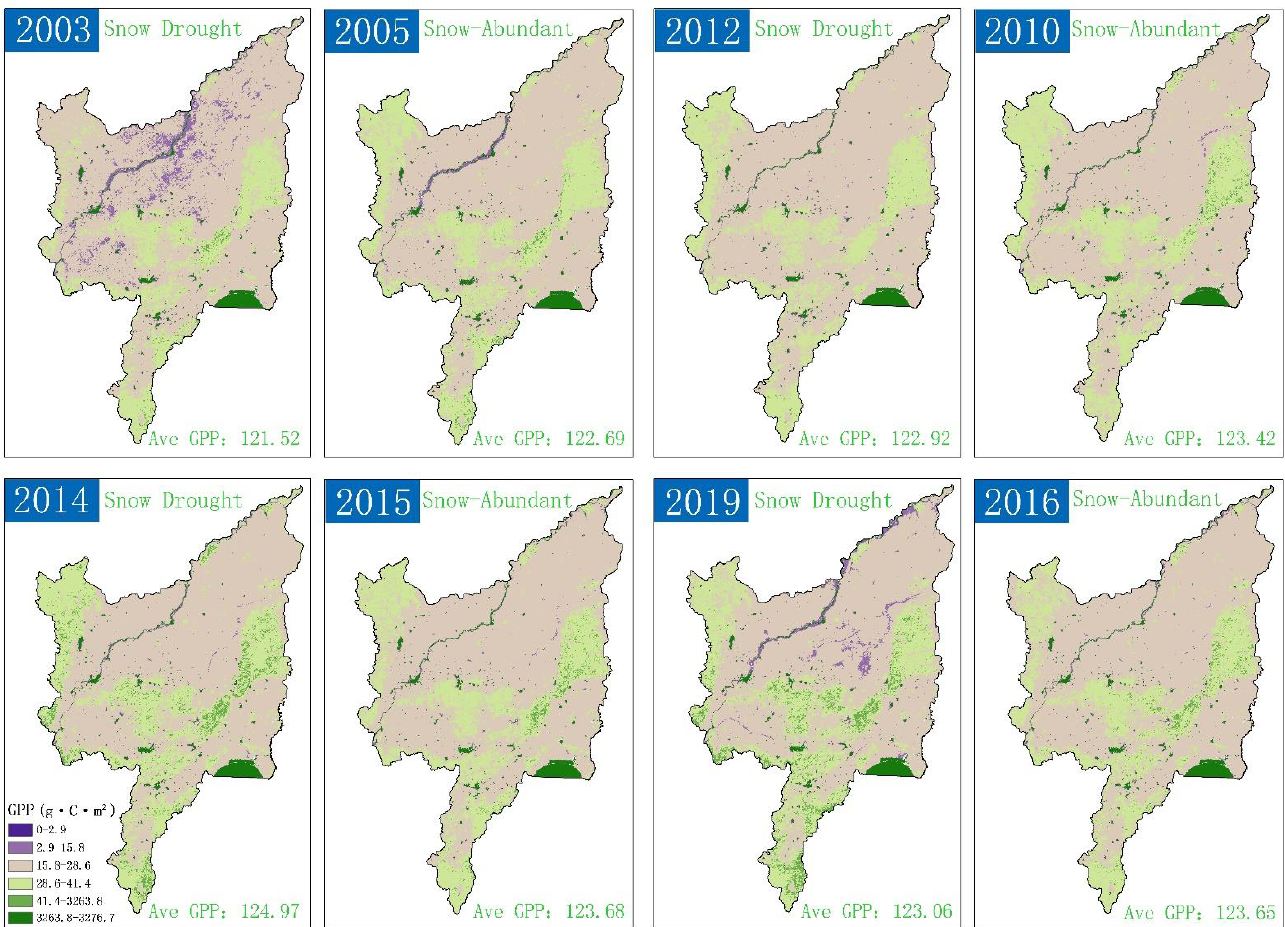
Figure 9. The spatial distribution of the gross primary productivity (GPP) in the Sanjiang Plain. Each picture is the average GPP value from each year’s March to October. Ave GPP: average GPP value (kg·C·m 2 ) in each year.